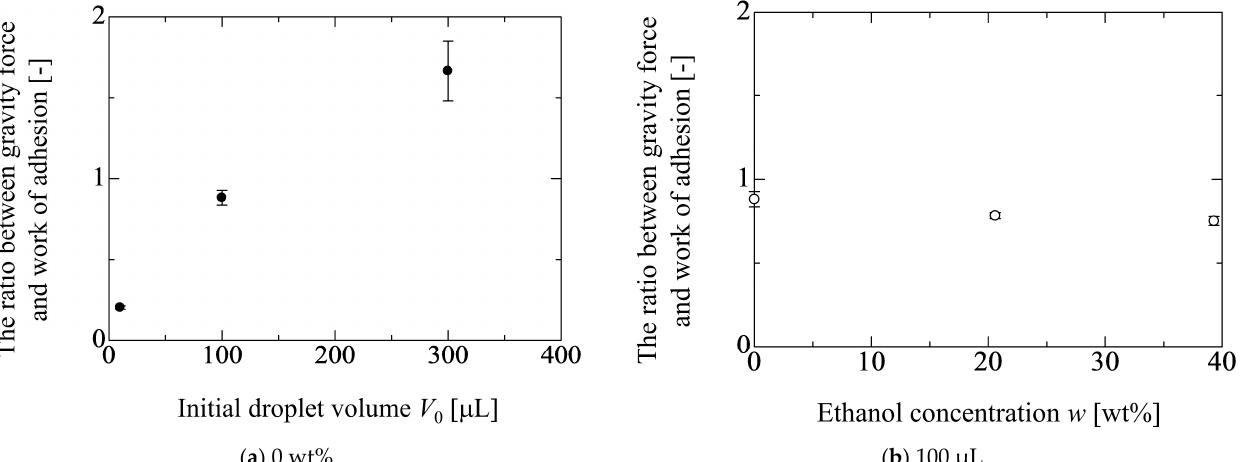
Figure 5. Ratio between gravity force per unit contact line and the work of adhesion. The ratio is calculated by mg /( π D 0 σ lg (1 + cos θ 0 ).